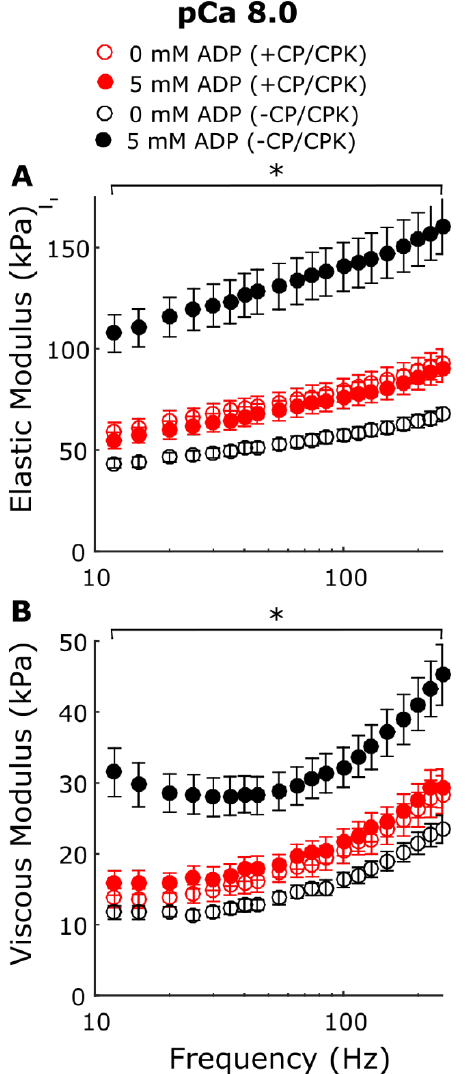
Figure 4. Tension increased with increased [ADP] under low [Ca 2+ ] (pCa 8.0) relaxing conditions. Steady-state isometric stress (= force per cross-sectional area) was plotted against [ADP] in the pres- ence and absence of CP and CPK. Nested two-way linear mixed models analysis showed main ef- fects of ADP ( p < 0.001), CP/CPK ( p = 0.03), and an ADP*CP/CPK interaction ( p < 0.001), with * indi- cating a Fisher’s LSD difference between − CP/CPK and +CP/CPK at a single [ADP] at p < 0.05. n fibers was 10 for each group, from two hearts.